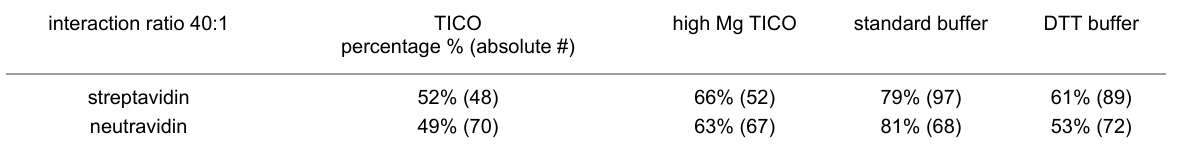
Table 1: Interaction rate of streptavidin- and neutravidin-DNA coupled to anti-DIG beads with the ratio 40:1 in various buffers. interaction ratio 40:1